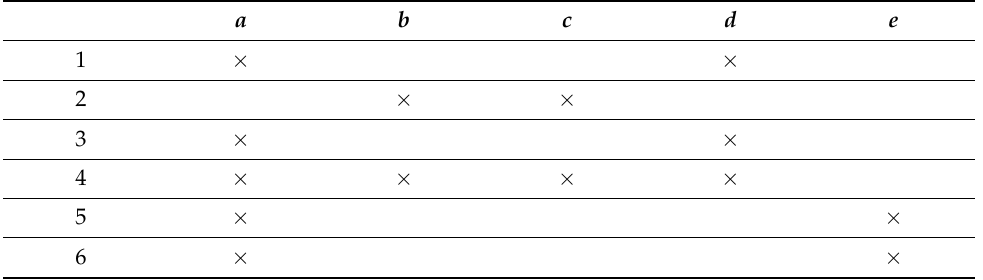
Table 2. Another example formal